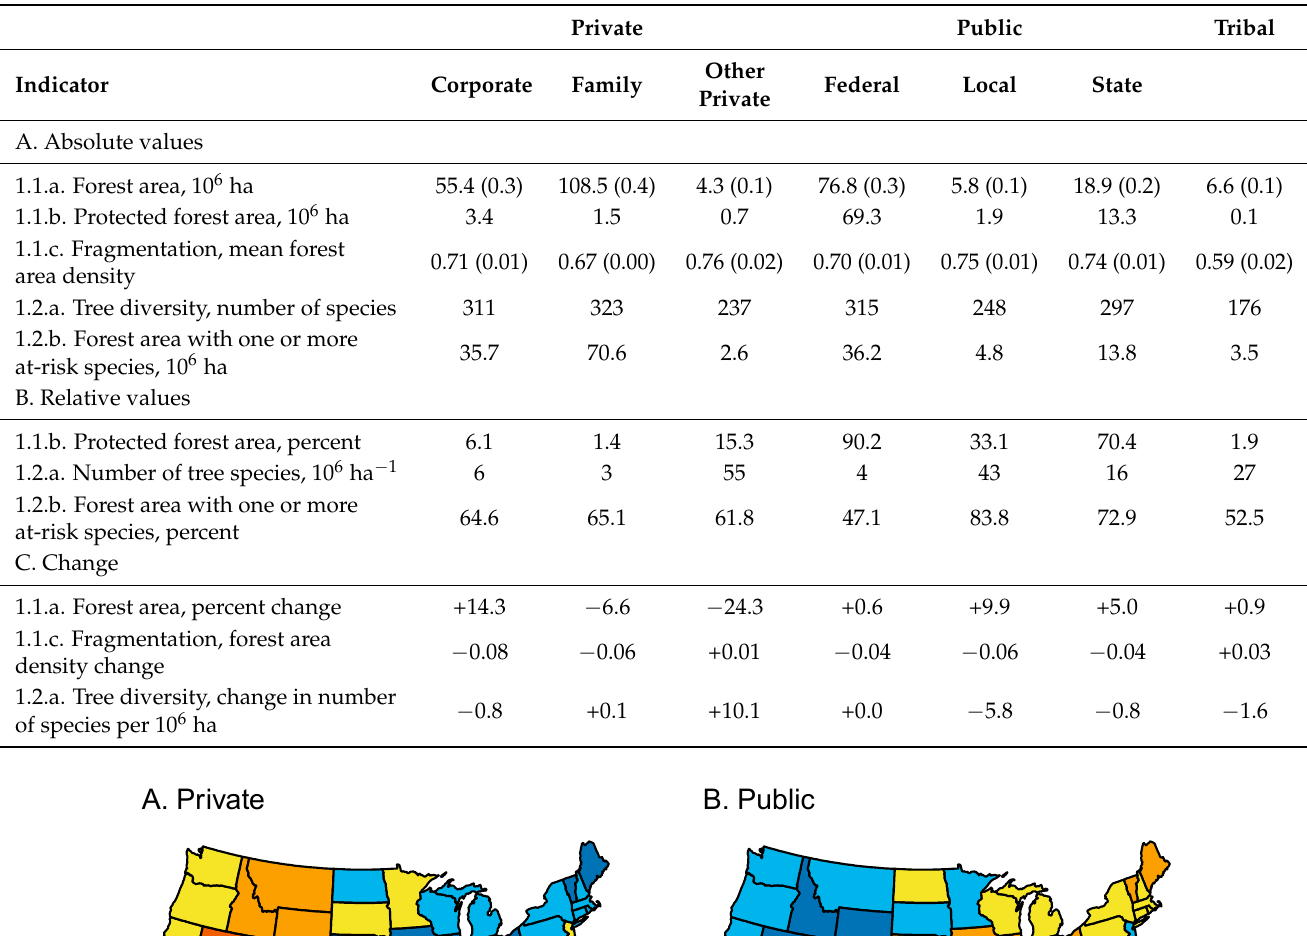
Table 3. Summary of selected Montr é al Process Criterion 1 Indicators by ownership category, conterminous USA in terms of: (A) absolute values (2019), (B) relative values (2019), and (C) change (2012–2019). Indicators, including data sources, are described in Table 1. Where available, standard errors are listed parenthetically following the estimates.